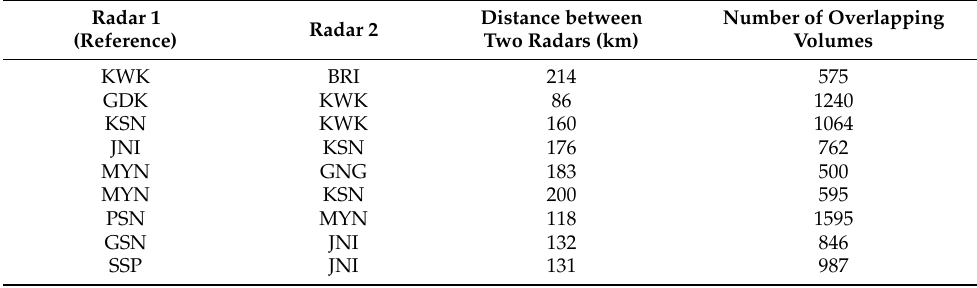
Table 3. Distance and the number of overlapping volumes for the matched radar pair.